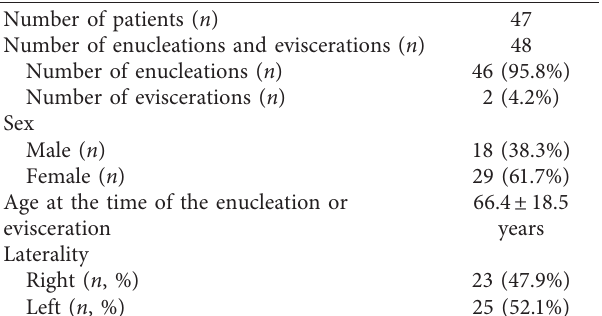
Table 1: Demographic characteristics of patients who underwent enucleation or evisceration due to infectious keratitis between January 2007 and December 2018 at the Department of Oph- thalmology of Semmelweis University (Budapest, Hungary) (48 eyes of 47 patients).